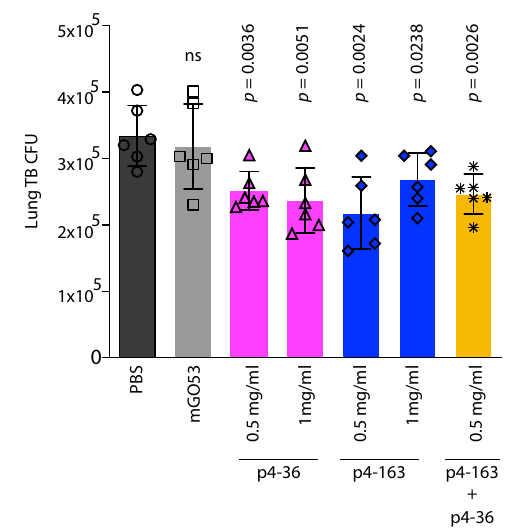
Fig. 6 Anti-PstS1 mAbs inhibit Mtb in Balb/c mice. Activity of anti-PstS1 mAbs: p4-36 (magenta bars), p4-163 (dark-blue bars), as well as the negative control mAb mGO53 (gray bars) at indicated concentrations in Balb/c mice. Mice were injected once intraperitoneally with mAbs at indicated amounts 5 hours prior to aerosol infection with pathogenic Mtb. Mice were euthanized after 2 weeks, and lung bacterial burden measured. Error bars are represented as mean±SD. In each treatment n = 6 mice. Signi fi cance was determined using a two-tailed unpaired t test. ns no signi fi cance. The results are representative of three independent